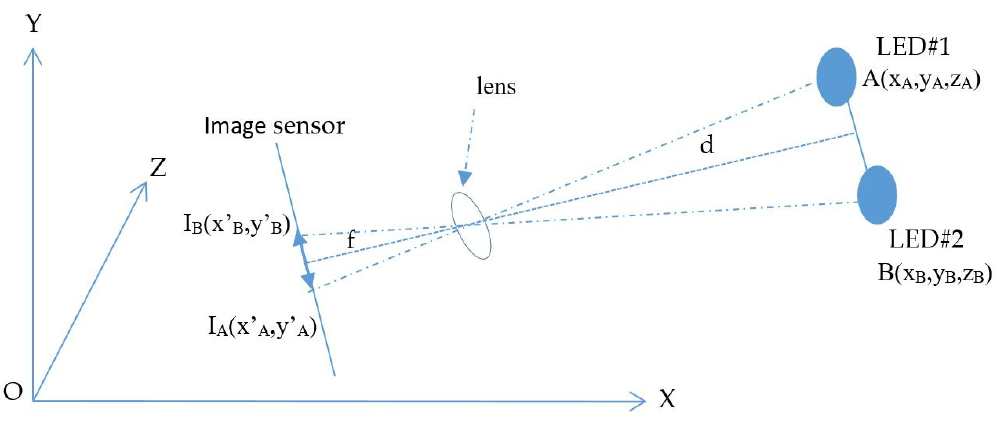
Figure 2. Distance-estimation-based photography technique.